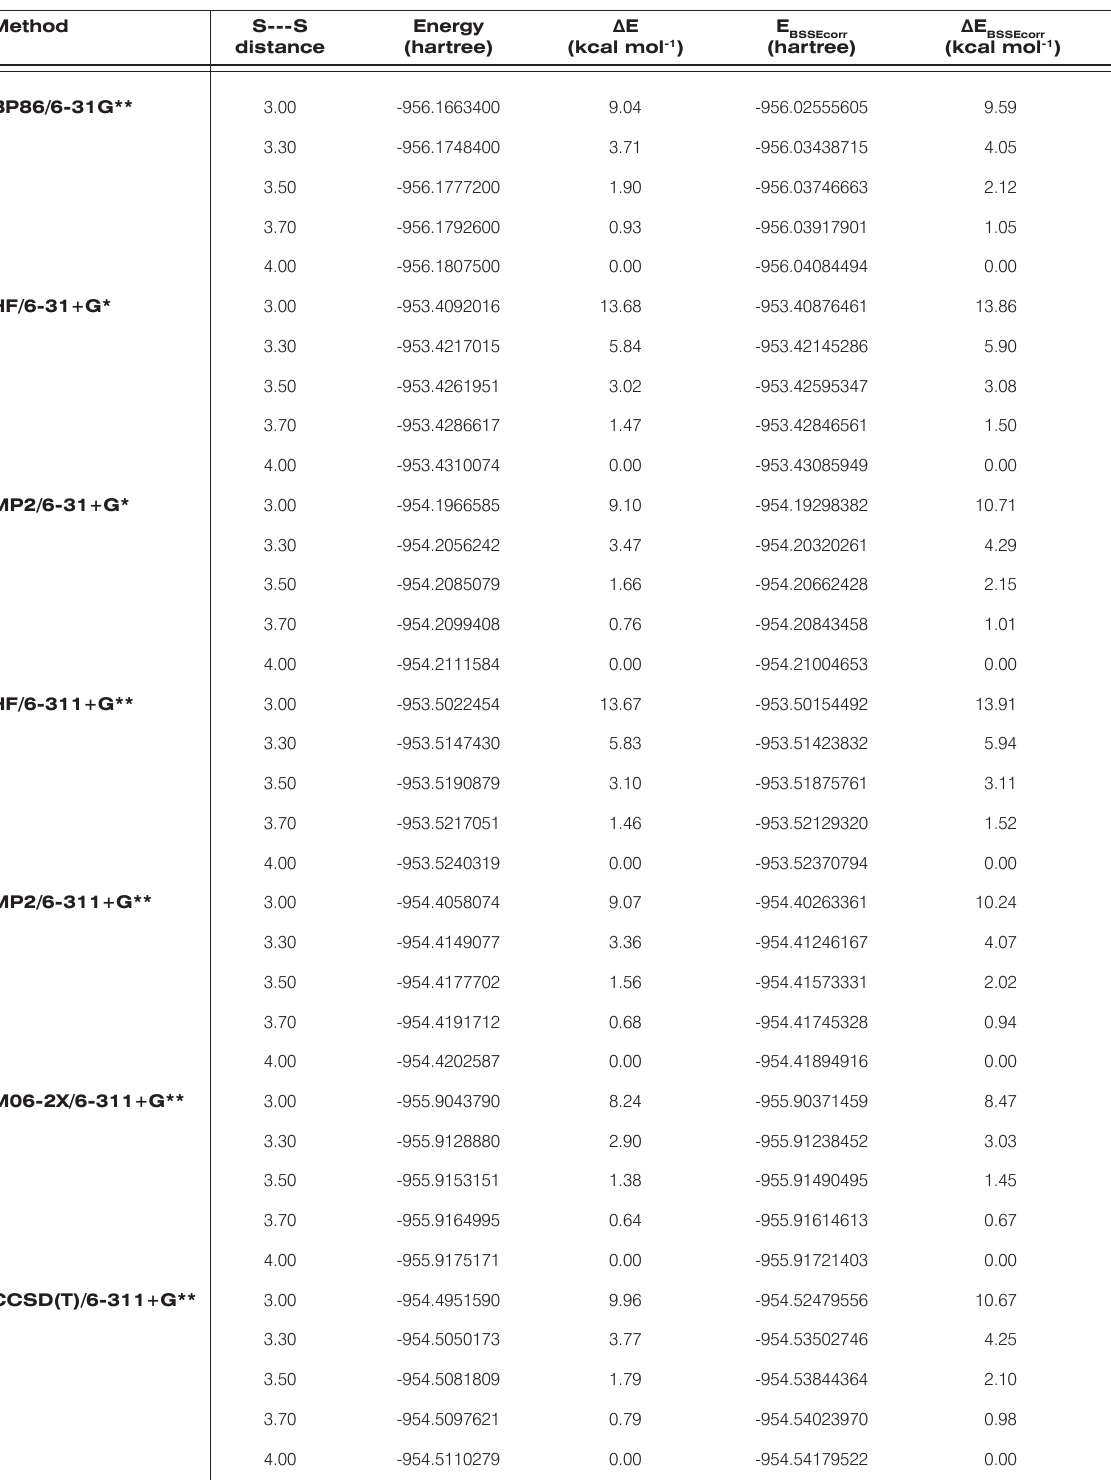
energies of the dimethyl thioether, computed at several levels of theory. For each method, the lowest-energy geometries are set as arbitrary references. Energy values were obtained on models built as described in the text, varying the S---S distance and then computing energies without further geometry Method